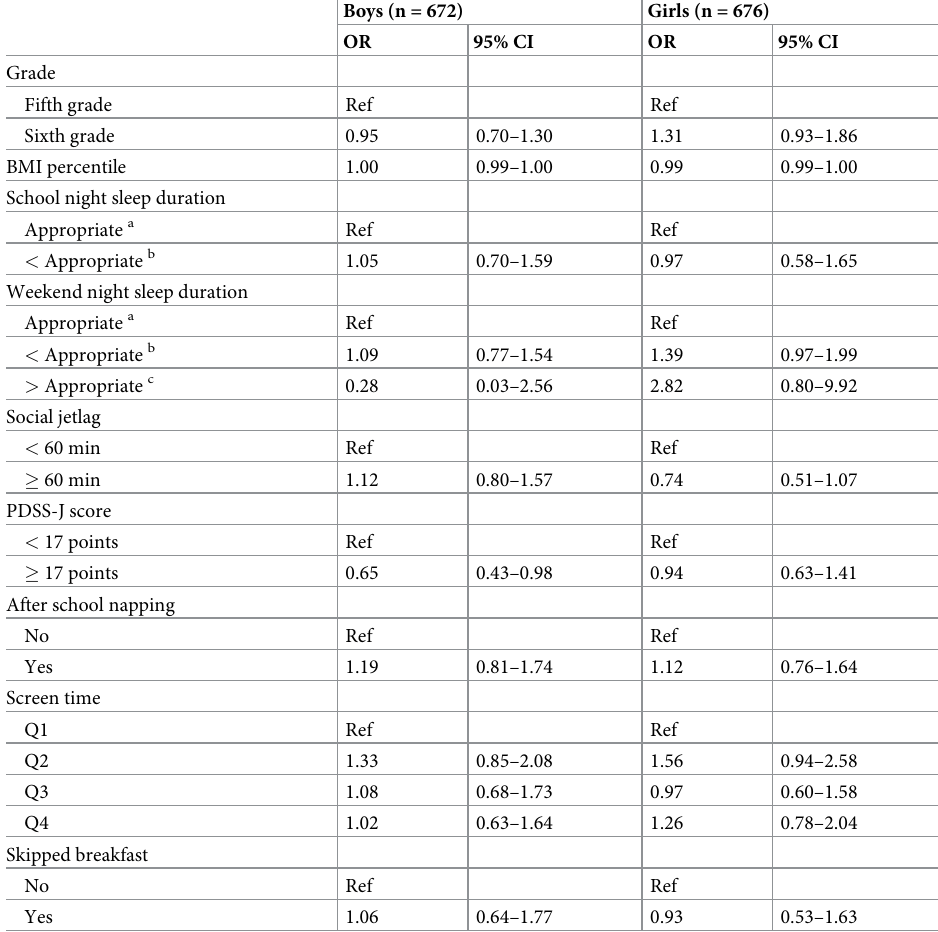
Table 2. Sleep habits relating to physical activity in elementary school students (fifth and sixth